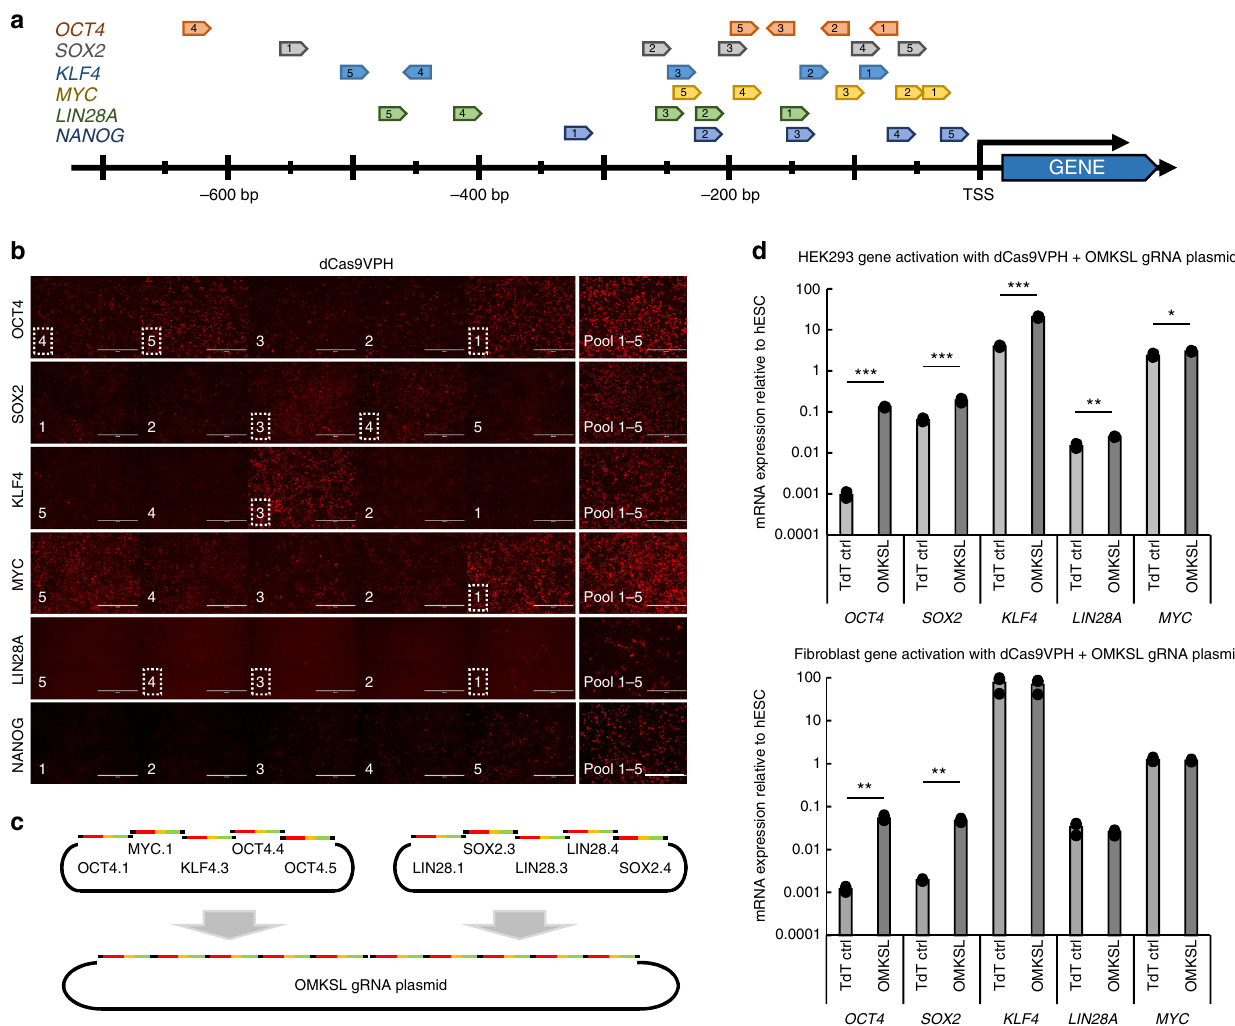
Fig. 2 Optimization of dCas9 activator and gRNA targeting in HEK293 for reprogramming factor activation. a Locations of promoter targeting gRNAs for reprogramming factors ( OCT4, SOX2, KLF4, C-MYC, LIN28A , and NANOG ) in relation to transcription start site. b Immunocytochemical staining of reprogramming factors after single gRNA activation and pooled mixture of fi ve guides in HEK293 with dCas9VPH. Pictures are in similar order to guides in Fig. 2a. Best performing guides used for plasmid cloning are marked with dotted lines. Scale bar = 400 µ m. c Schematic representation of concatenated reprogramming factor gRNA plasmid construction. d Reprogramming factor activation by qRT-PCR, in HEK293 cells 3 days after transfection and HFFs 4 days after electroporation, using transiently expressed dCas9VPH effector. n = 3, data are from three independently treated samples. Data presented as mean ± s.e.m., two tailed Student ’ s t -test. * P < 0.05, ** P < 0.01, *** P <